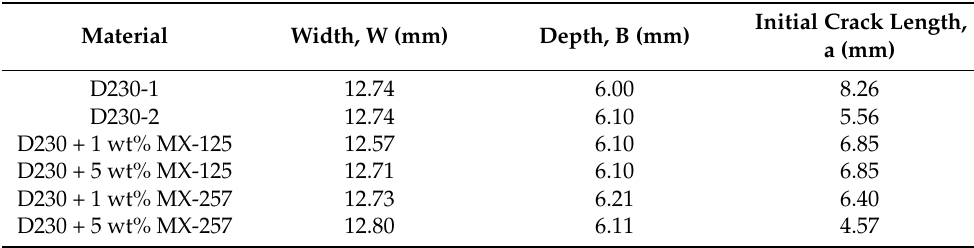
Table 1. Dimensions of the epoxy resin samples analyzed with the single-edge notched bending (SENB) test. All samples tested had a length of 63 mm.